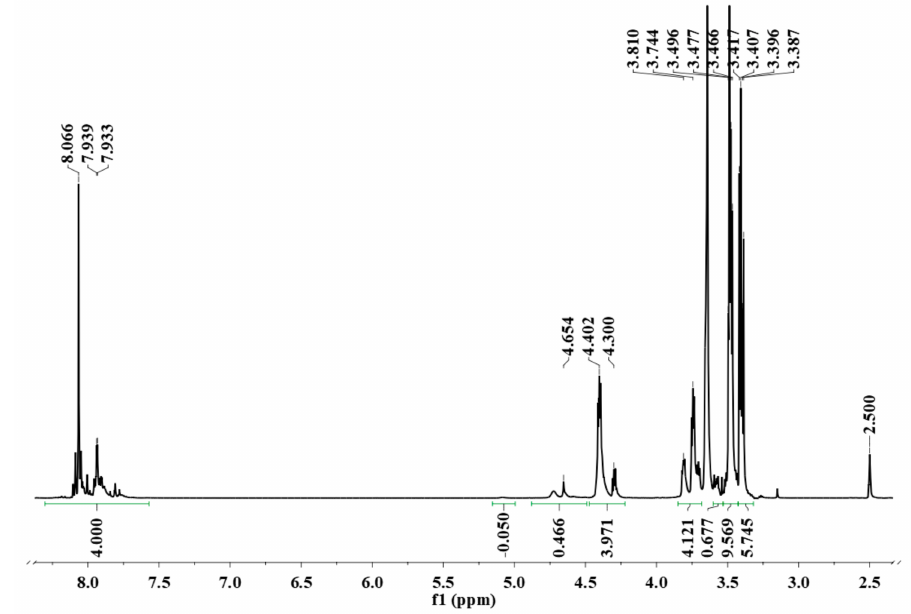
Figure 2. 1 H-NMR spectrum (DMSO-d 6 -D 2 O) of DZS